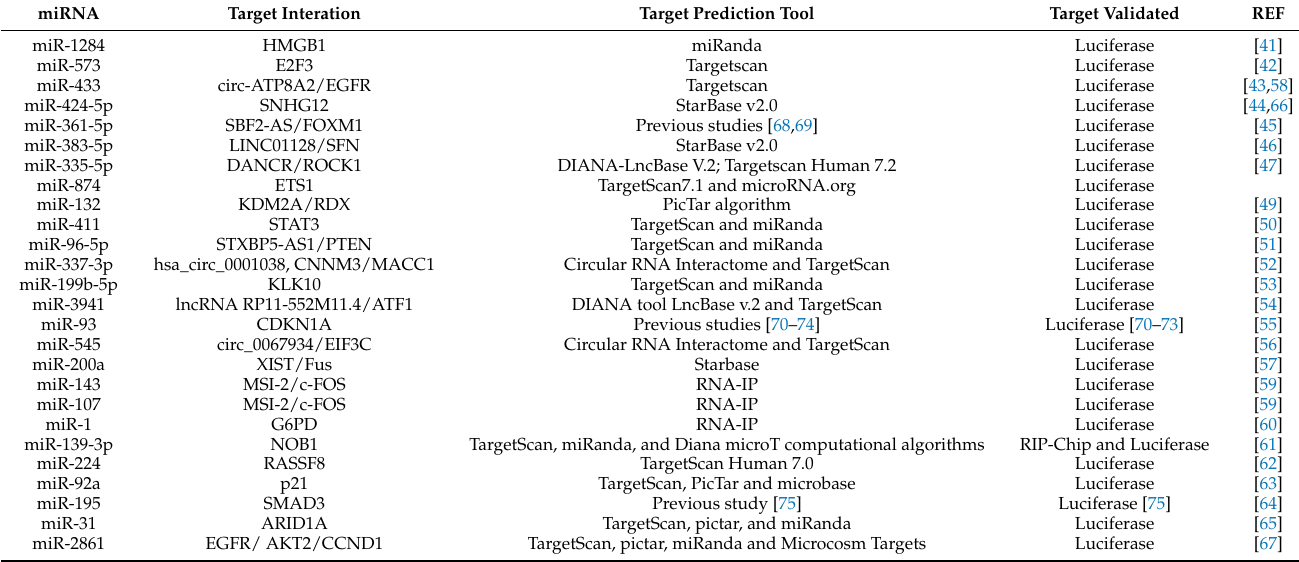
Table 3. Differential expression of microRNAs (miRNAs) and targets genes in cervical cancer (CC) samples and cell lines. miRNA